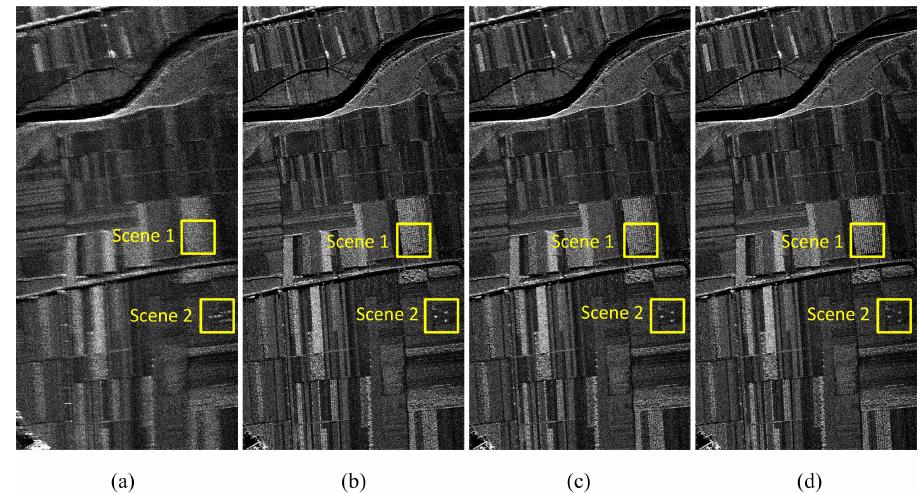
Figure 14. X-band UAV SAR Images processed by different autofocus strategies. ( a ) Processed with INS-only MOCO. ( b ) Processed with conventional MDA. ( c ) Processed with RDMDA. ( d ) Processed with